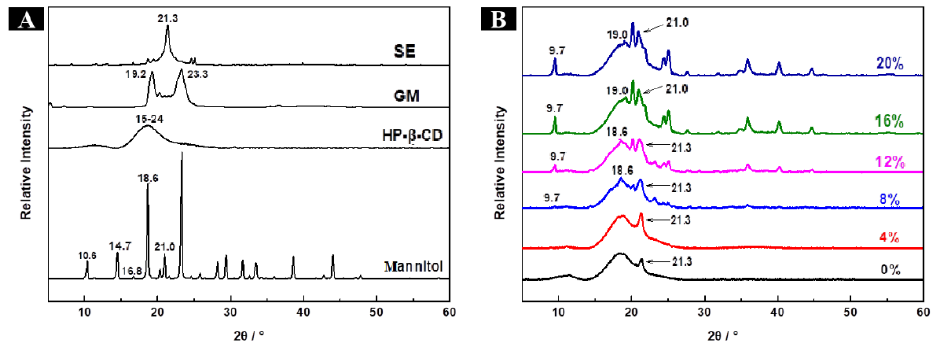
Figure 8. XRD patterns of ( A ) raw materials (HP- β -CD, mannitol, glyceryl monostearate, and sugar esters) and ( B ) HP- β -CD/MAN microcapsules with 0–20% MAN